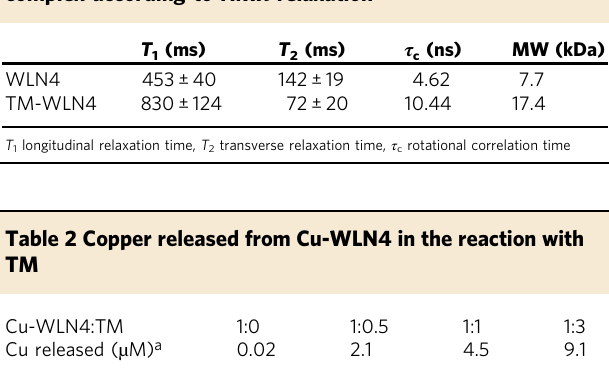
Table 1 Estimation of molecular size of the TM-WLN4 complex according to NMR